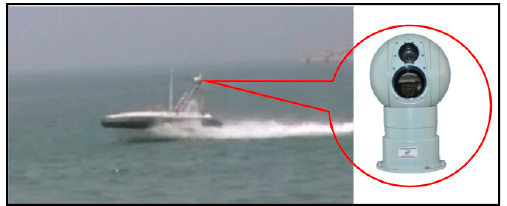
Figure 10. “XL” USV and the optoelectronic imaging unit.